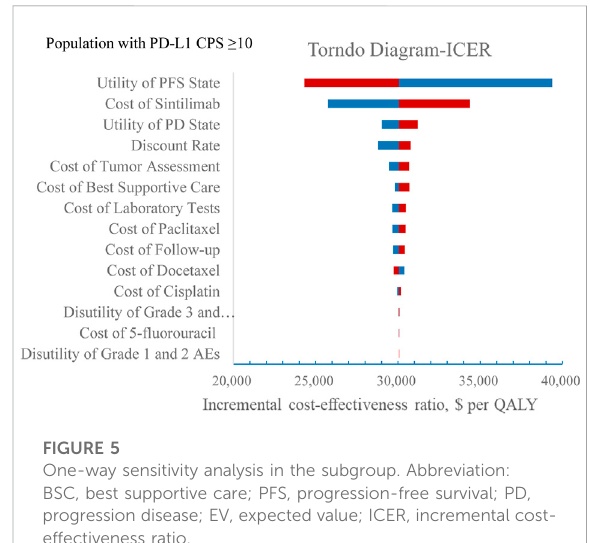
FIGURE 5 One-way sensitivity analysis in the subgroup. Abbreviation: BSC, best supportive care; PFS, progression-free survival; PD, progression disease; EV, expected value; ICER, incremental cost- effectiveness